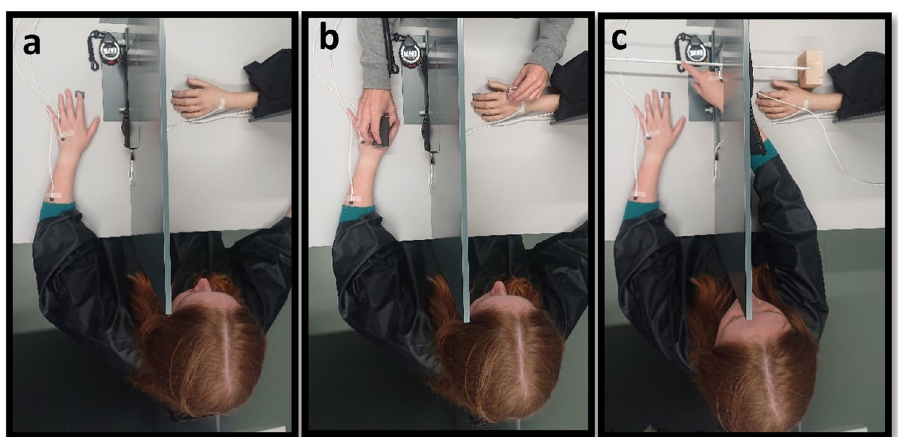
Fig. 6 Experimental setup for Experiment 2. a The two Biopac thermosensors on the left arm and hand are visible. The rubber hand had the same sensors to avoid any mismatch between the real and the rubber hand. b The thermode of the Somedic MSA Thermal Stimulator was used to deliver a touch at 24 °C or 32 °C on the participant ’ s left hand, while participants watched the rubber hand being touched by an ice cube. c Visual representation of the proprioceptive drift